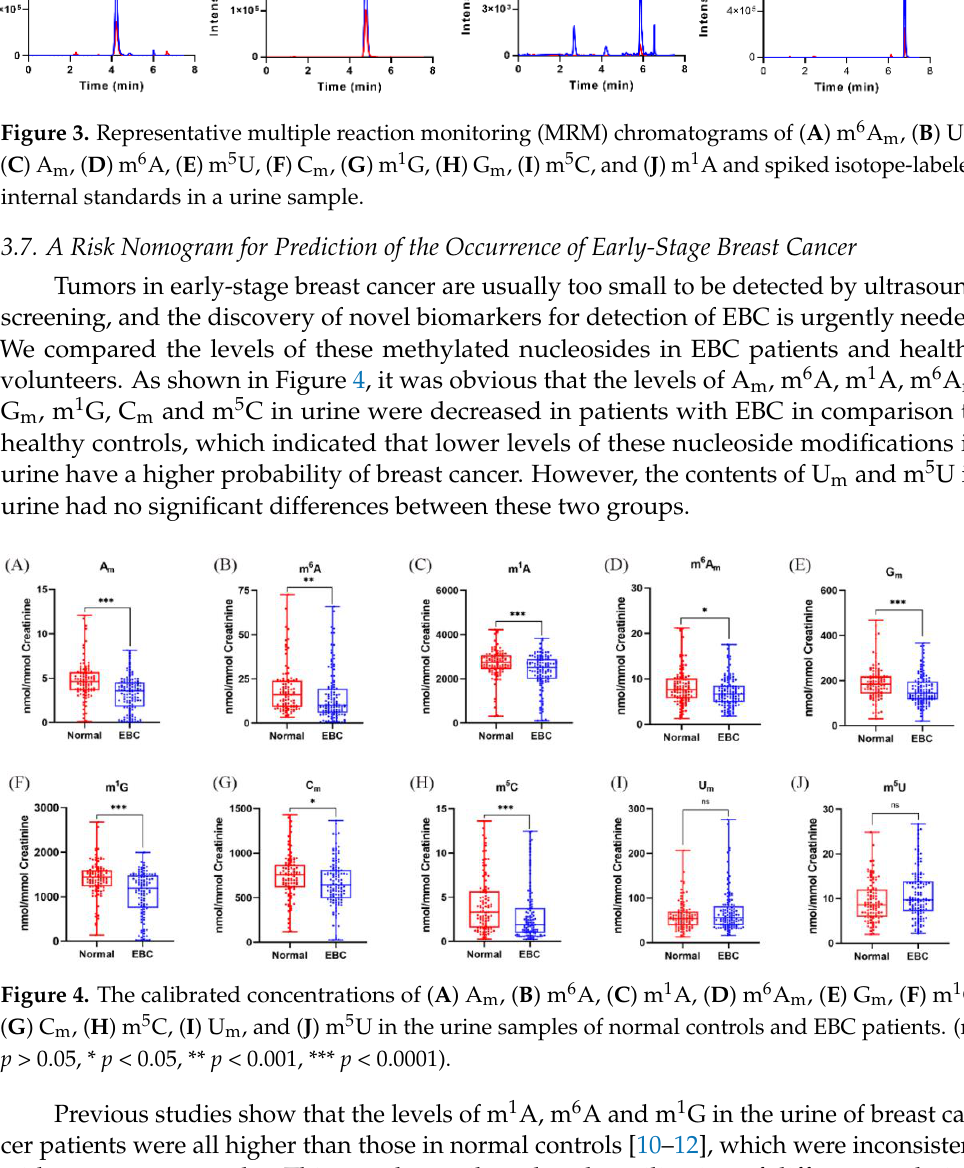
Figure 3. Representative multiple reaction monitoring (MRM) chromatograms of ( A ) m 6 A m , ( B ) U m , ( C ) A m , ( D ) m 6 A, ( E ) m 5 U, ( F ) C m , ( G ) m 1 G, ( H ) G m , ( I ) m 5 C, and ( J ) m 1 A and spiked isotope-labeled internal standards in a urine sample.